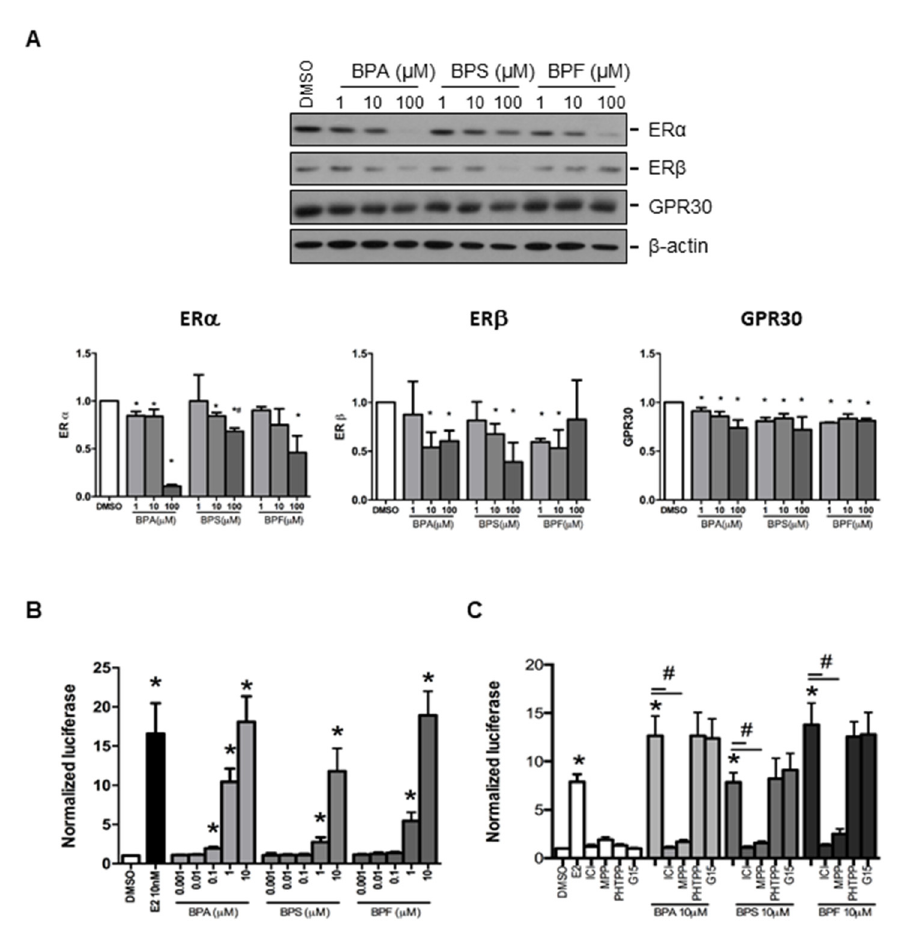
Figure 2. Effect of BPA, BPF, and BPS on the expression of ER α , ER β , and GPR30 in Ishikawa cells. ( A ) Western blot analysis of the expression of ER α , ER β , and GPR30 in Ishikawa cells treated with different concentrations of BPA, BPF, and BPS for 24 h (Top panel, n = 3). Semi-quantitative analysis of the Western blot images. ( B ) BPA, BPF, and BPS transactivated the 3xERE-TATA-Luc vector in transfected Ishikawa cells. Dual-Glo luciferase assay was used to detect the luciferase signal ( n = 3). ( C ) Effect of ICI 182,780 (estrogen receptors antagonist), MPP dihydrochloride (estrogen receptor α -specific antagonist), PHTPP (estrogen receptor β -specific antagonist), or G15 (GPR30 antagonist) on the transactive effects of BPA, BPF, and BPS in transfected Ishikawa cells ( n = 3). Estradiol at 10 nM was used as the positive control in all the transfection experiments, whereas DMSO was used as the solvent control. Signals were normalized to the Renilla signal in the co-transfected plasmid. Effect of ICI 182,780 (estrogen receptors antagonist) and G15 (GPR30 antagonist) on spheroid attachment on treated Ishikawa cells. DMSO and MTX (5 μ M) were used as the negative and positive controls in the spheroid attachment assay. The number of attached spheroids over the total spheroids added is shown on the graph. * denotes p < 0.05 compared with DMSO and # denotes p < 0.05 compared with 10 µ M bisphenol indicated in respective